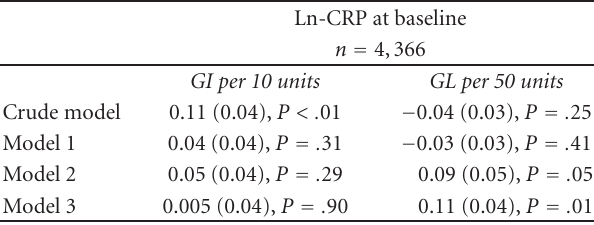
Values are beta-coe ffi cients with SEE. Model 1: adjusted for age, sex, smoking, and family history of diabetes. Model 2: as model 1 with additional adjustments for intake of energy, protein, saturated fat, alcohol, and fiber. Model 3: as model 2 with additional adjustment for